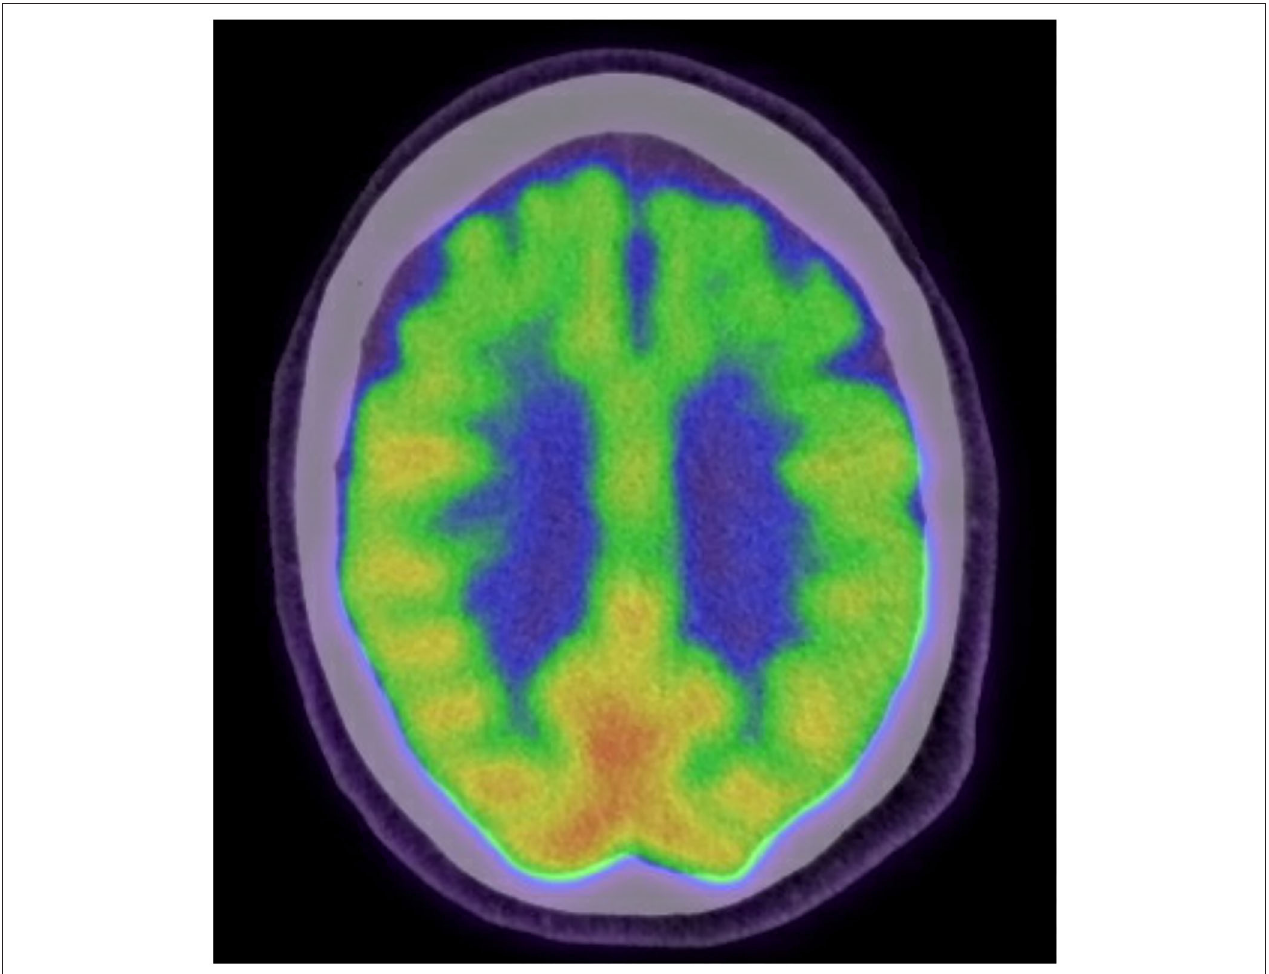
FIGURE 2 | The patient’s fluorodeoxyglucose (FDG)-positron emission tomography scan showing hypometabolic areas primarily in the left temporal lobe and biltateral frontal